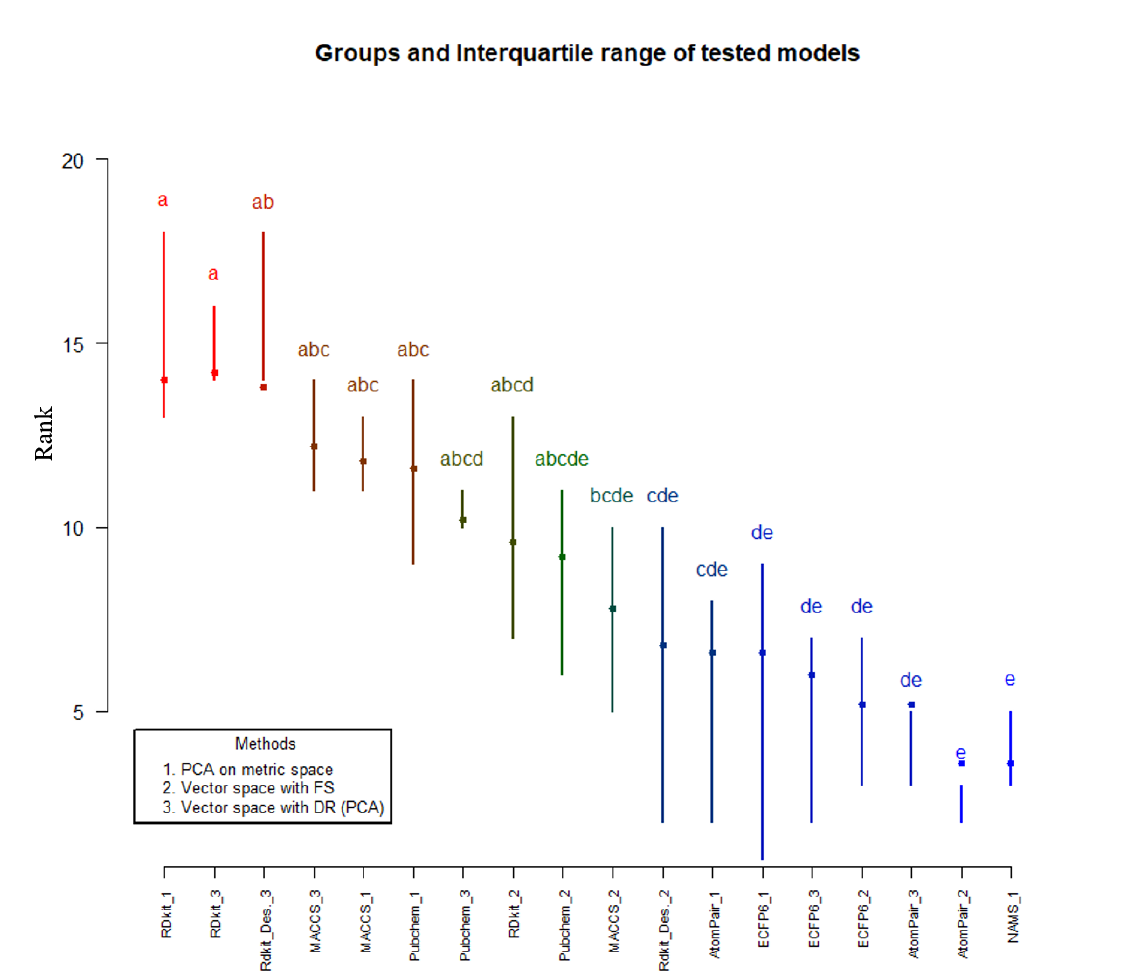
Figure 4. Friedman test results and interquartile ranges of tested